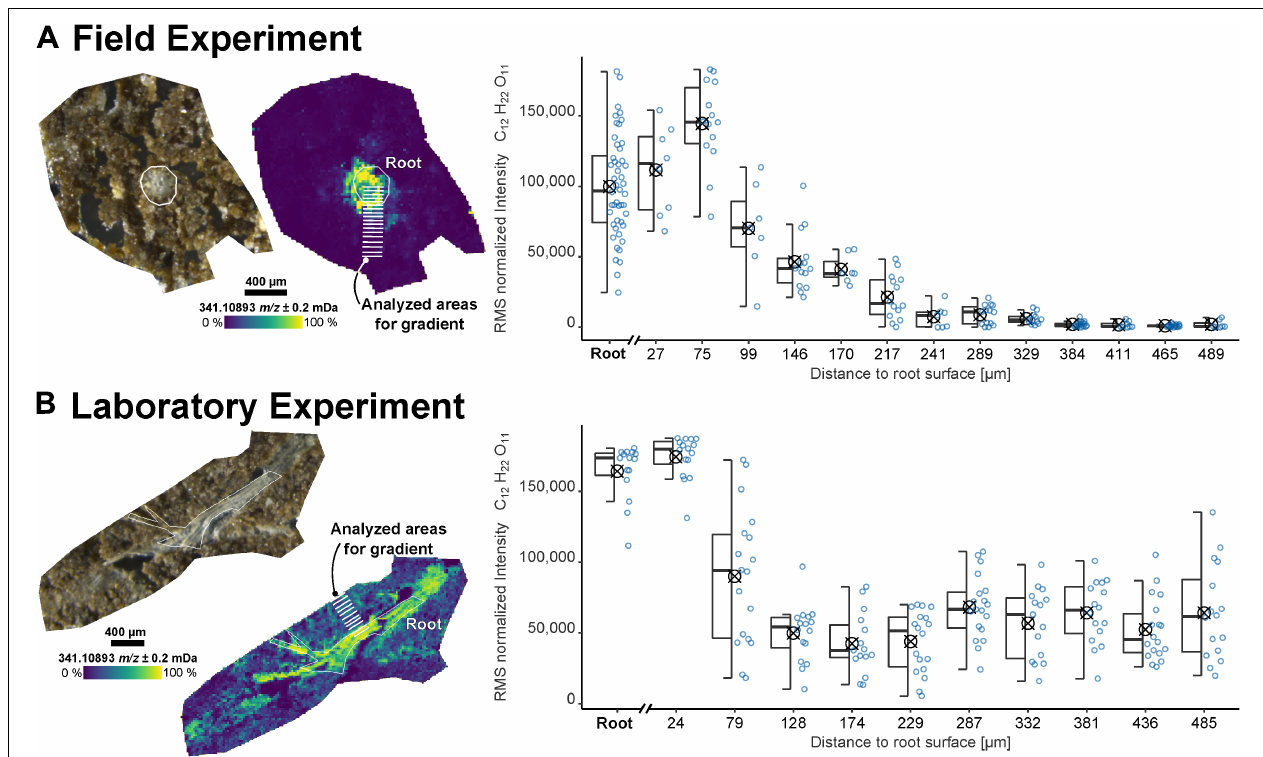
FIGURE 1 | Imaging results for samples from (A) the field experiment (FP1, root cross-section) and (B) a laboratory experiment (RB1-b1, root longitudinal section). Optical images of the soil sections and ion images for the dihexose [C 12 H 22 O 11 − H] − as detected by laser desorption ionization Fourier-transform ion cyclotron resonance mass spectrometry (LDI-FT-ICR-MSI) are shown on the left. The peak intensity of the dihexose signal [C 12 H 22 O 11 − H] − versus maximum distance to the root surface for selected areas (each covering 7 to 19 spectra, each spectrum represented by one blue dot) is shown on the right. The root surface is highlighted in white and the areas used to construct the boxplots (symbol indicates arithmetic mean) are highlighted in the ion images.